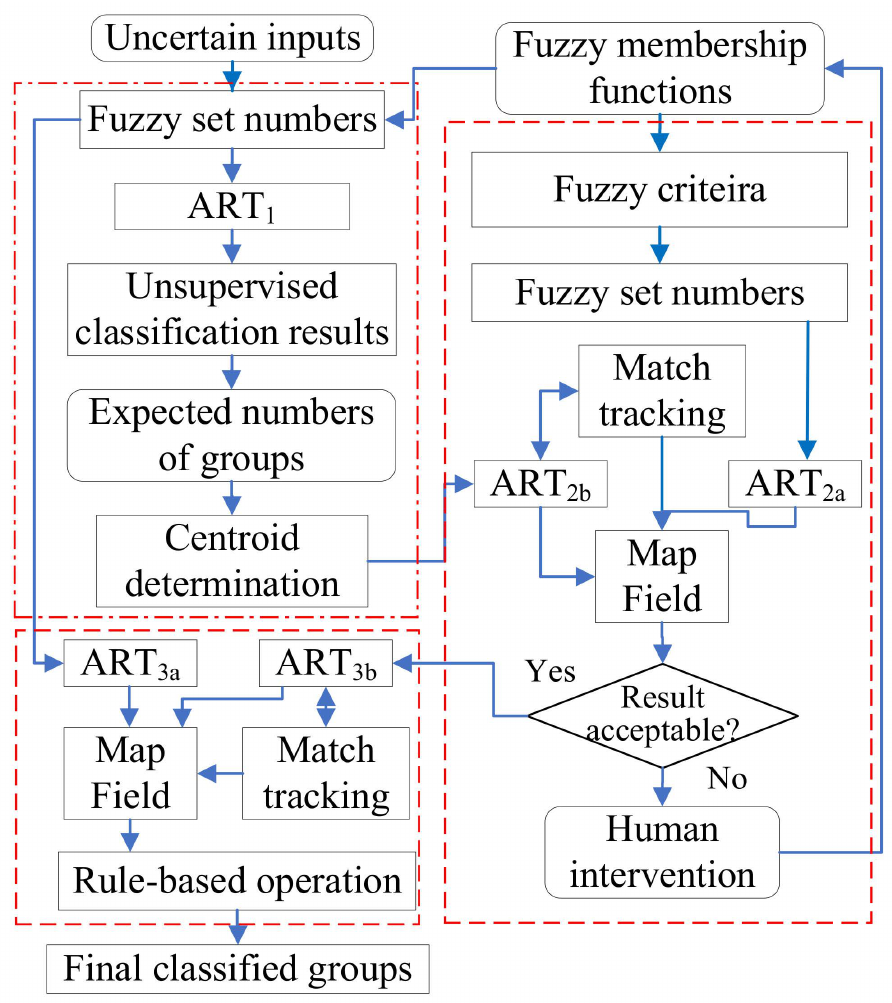
Figure 2. Framework of the IRFAM approach (adopt from Li et al. (2011)